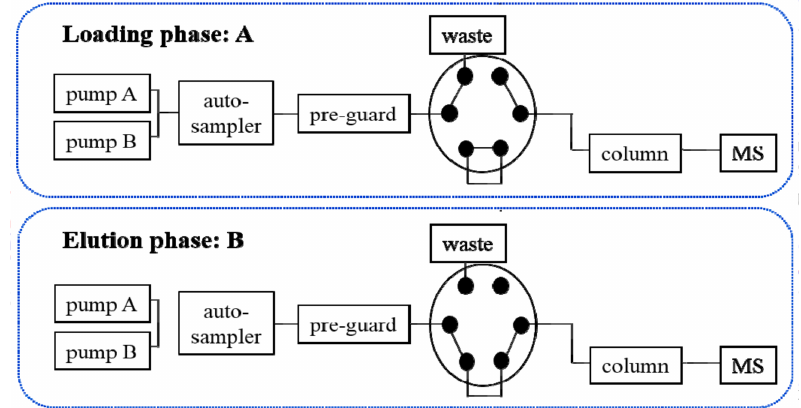
Figure 2. Connectivity sketch of the six-port / two-channel switching valve controlling the large volume direct injection ultra-high performance liquid chromatography–tandem mass spectrometry (LVDI-UHPLC-MS / MS) system. At the loading phase, the valve was maintained at A-channel. The sample delivered from the auto-sampler was captured onto a pre-guard column. Meanwhile, the pumps delivered the mobile phase at a high flow rate. Then, the valve was automatically switched to the B-channel to trigger the elution phase. The trapped components were flushed from the pre-guard column into an analytical